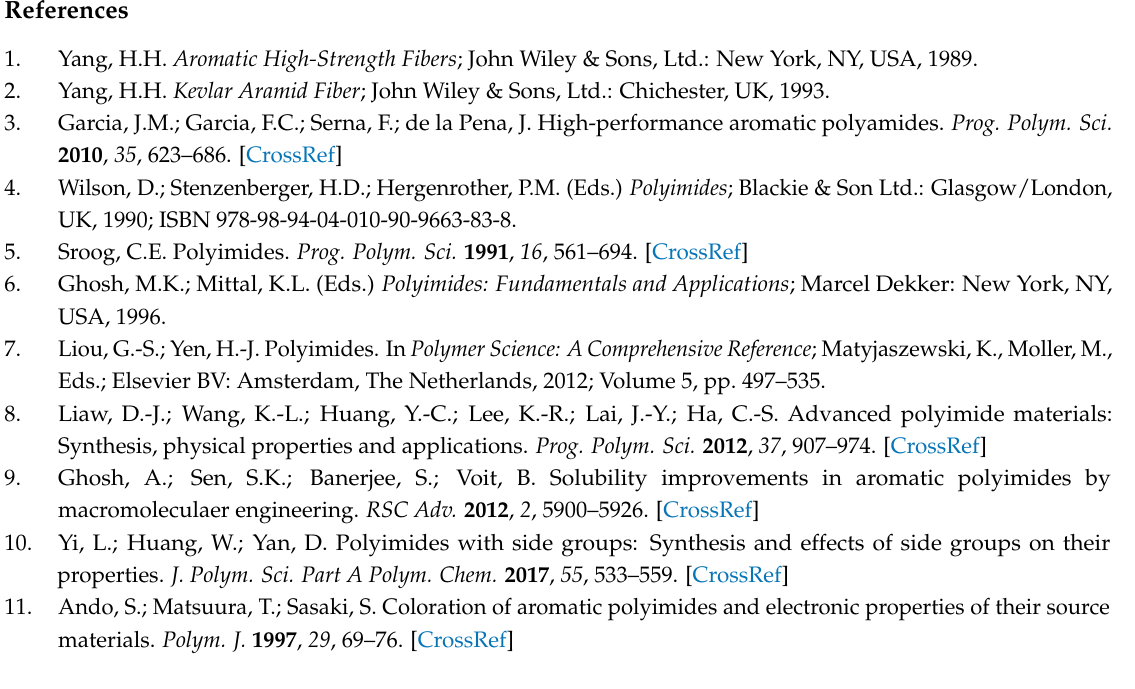
Figure S1: IR spectra of compounds 1 to 3 ; Figure S2: 1 H NMR spectra of compounds 1 and 2 in DMSO- d 6 ; Figure S3: Mass analysis of compounds 2 and 3 ; Figure S4: IR spectra of PAs 5a − 5e ; Figure S5: 1 H H-H COSY NMR spectra of polyamide 5a in DMSO- d 6 ; Figure S6: IR spectra of PIs 7a − 7c ; Figure S7: 1 H H-H COSY NMR spectra of polyimide 7b in DMSO- d 6 ; Figure S8: TGA curves of PAs 5c and 5d and PIs 7a − 7c ; Figure S9: Cyclic voltammogram of 1 mM ferrocene in 0.1 M Bu 4 NClO 4 /MeCN at a scan rate of 50 mV · s − 1 ; Figure S10: Cyclic voltammograms of PAs 5b – 5e films on the ITO-coated glass substrate in 0.1 M Bu 4 NClO 4 /MeCN at a scan rate of 50 mV · s − 1 ; Figure S11: Cyclic voltammograms of PIs 7b and 7c films on the ITO-coated glass substrate in 0.1 M Bu 4 NClO 4 /MeCN at a scan rate of 50 mV · s − 1 ; Figures S12–S16: Optical absorption spectra of PAs and PIs. Figure S17: Current monitored and optical transmittance changes of the PA 5b and PI 7a films while the potential was